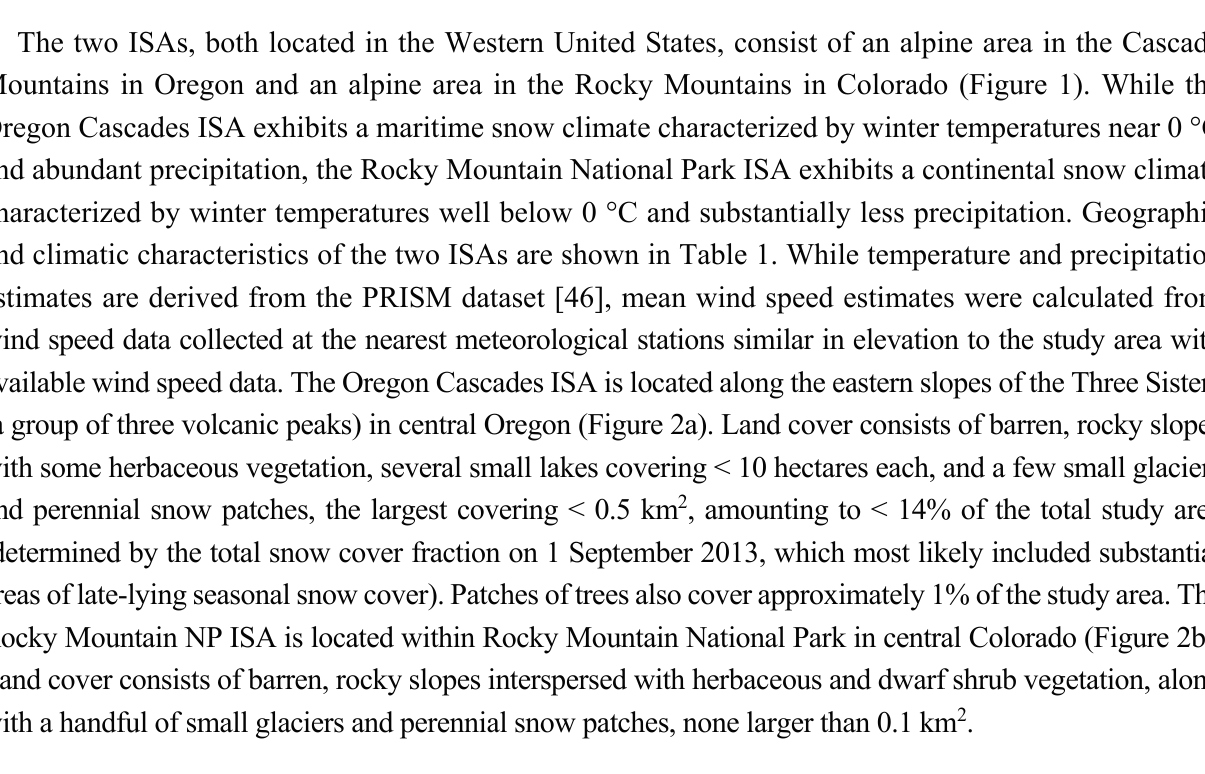
Table 1. Geographic and climatic characteristics for each study area. Climatic characteristics are derived from the PRISM Climate Dataset